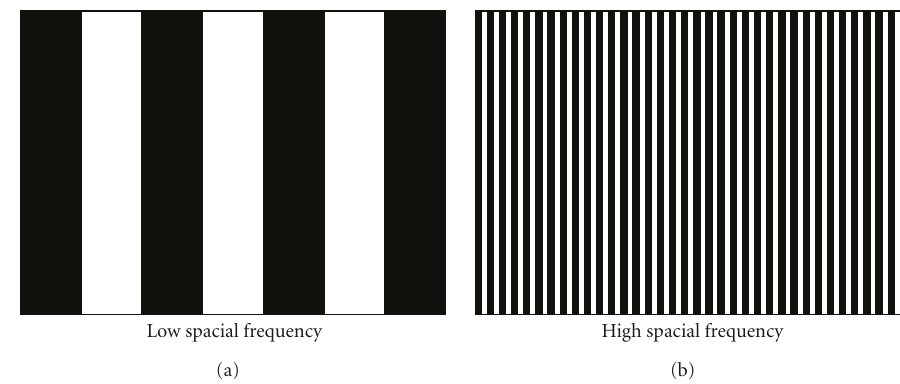
Figure 2: Patterns with low spatial frequency and high spatial frequency.